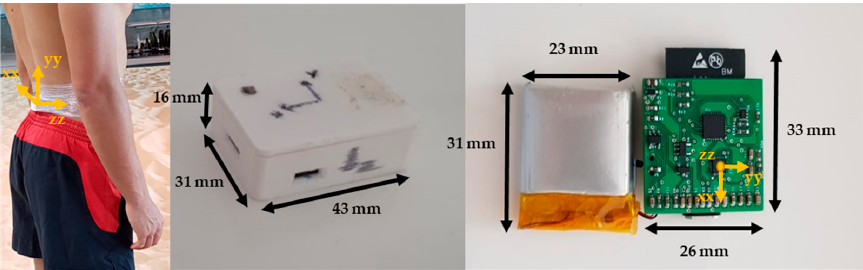
Figure 1. An example of the IMU location at position L5 and the instrument developed by the investigation group.